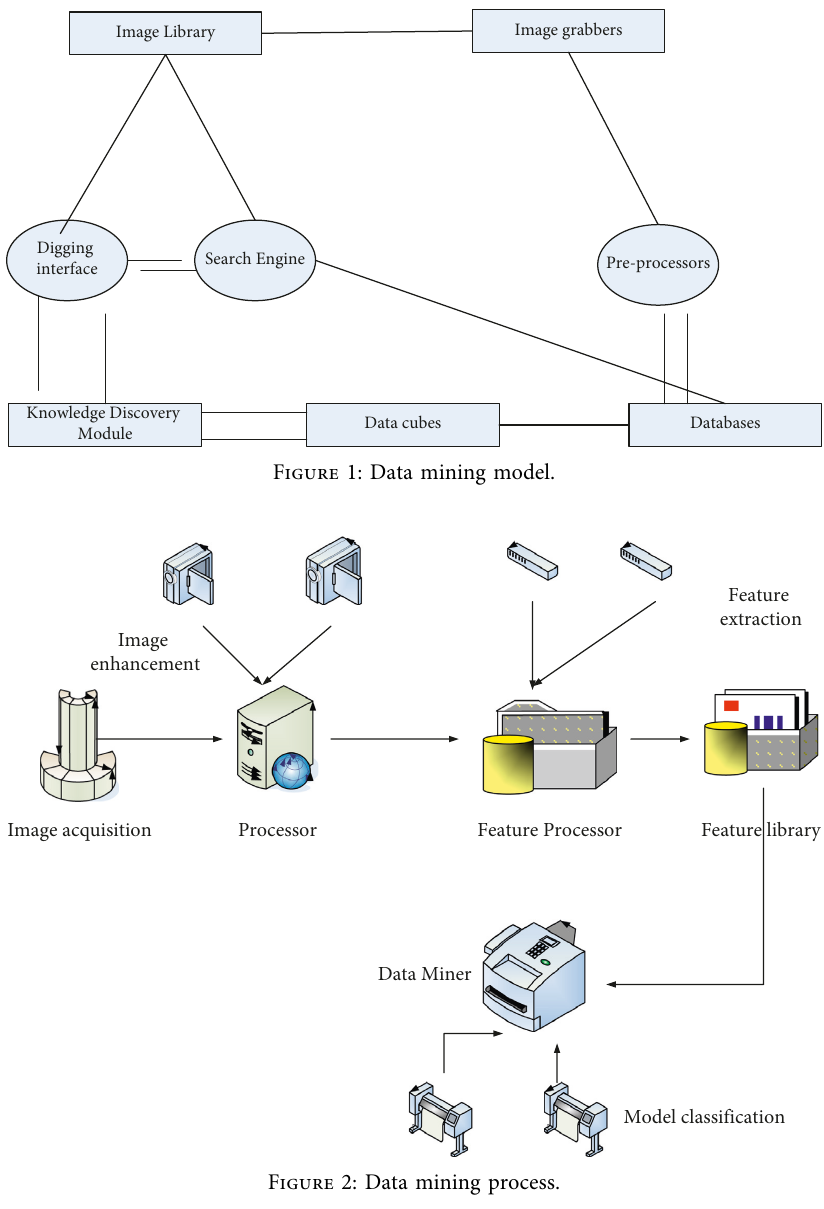
Figure 1: Data mining model.